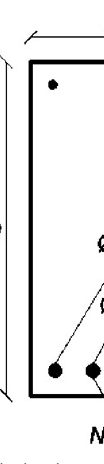
Figure 6. Optimization problem design